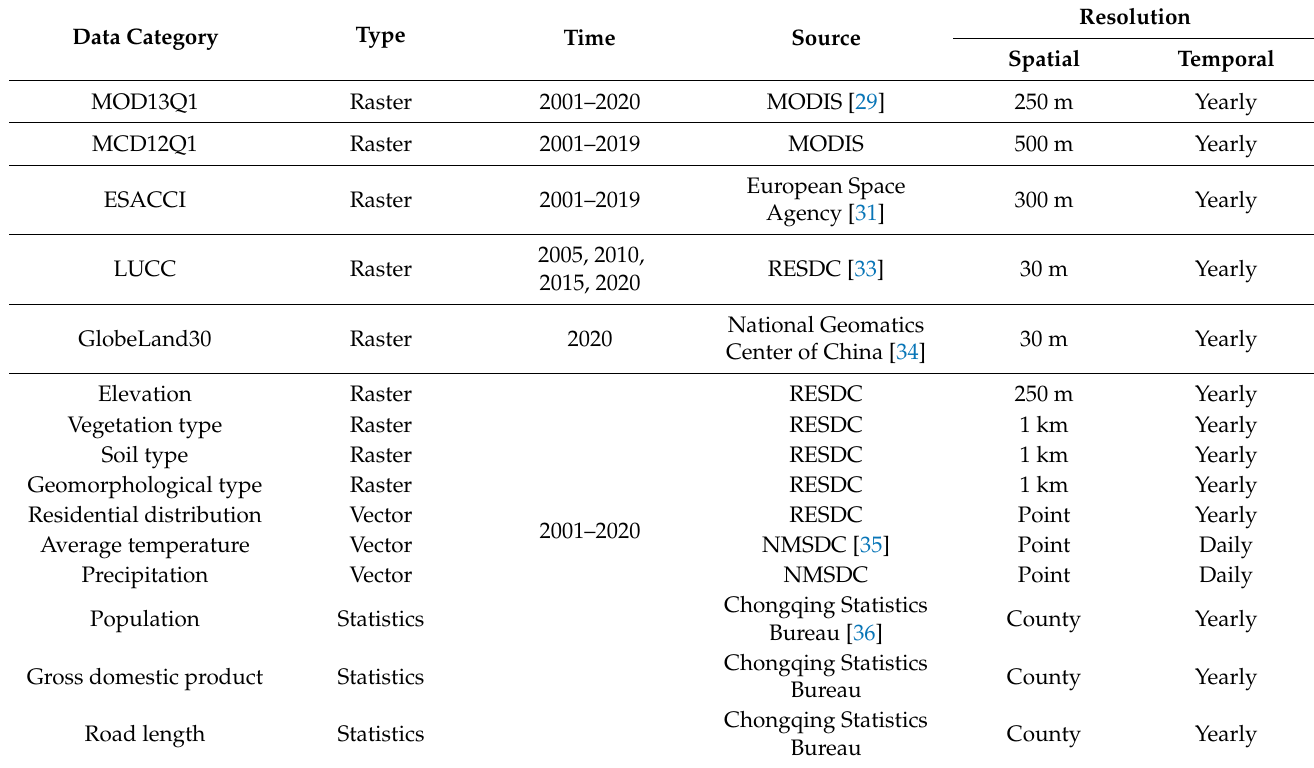
Table 1. Basic data and